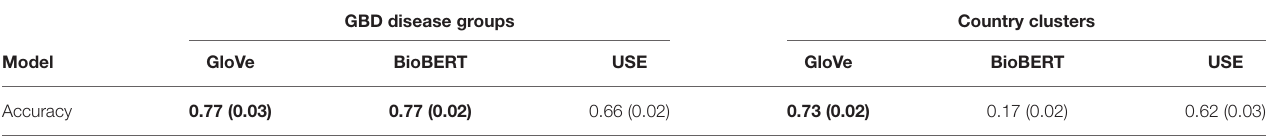
TABLE 1 | Classification results for GBD disease groups using disease embeddings and country clusters with country